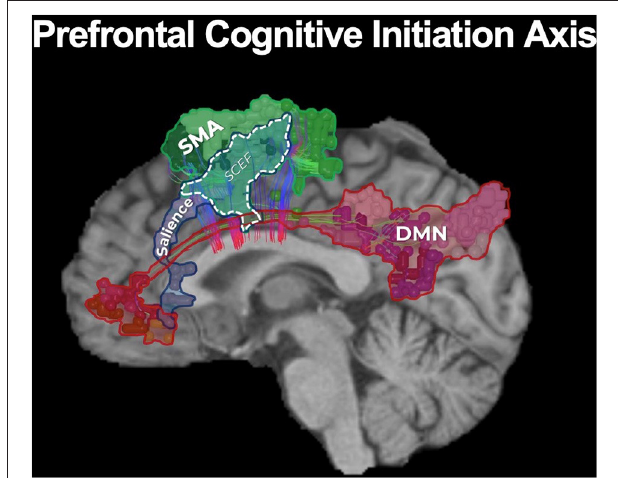
FIGURE 4 | The prefrontal cognitive initiation “axis.” Our model of the initiation axis suggests that the DMN, connected via the cingulum, and the SN, connected via the frontal aslant tract (FAT), create a structural chain that extends up to the SMA in the medial frontal lobe ( 77). In fact, the SMA and salience networks share a node known as SCEF (supplementary and cingulate eye field). The identity and functional relevance of these connections have been supported by multiple lines of evidence (85), together suggesting this initiation “axis” is likely responsible for internally modeling goal initiation, such as with the initiation of speech and motor planning. Unsurprisingly, disruption of the integrity of this “axis” when operating on a tumor in the medial frontal lobe can lead to akinetic mutism and abulia ( 14, 82,